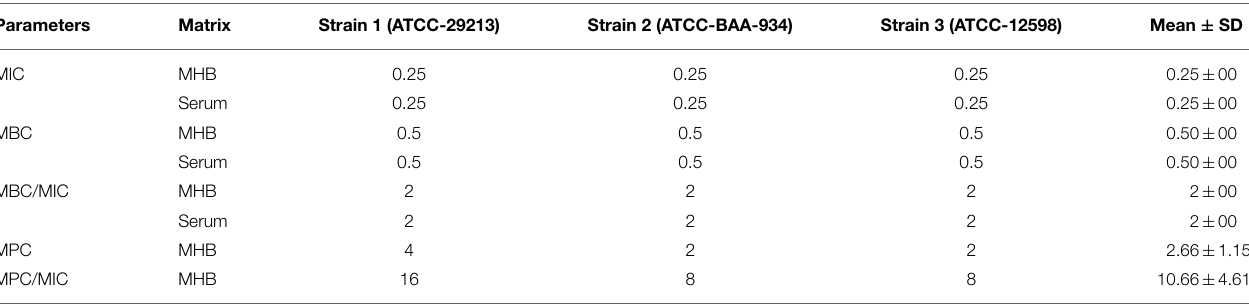
TABLE 2 | MIC, MBC and MPC ( µ g/ml) of Cefquinome against staphylococcus aureus . Parameters Matrix Strain 1